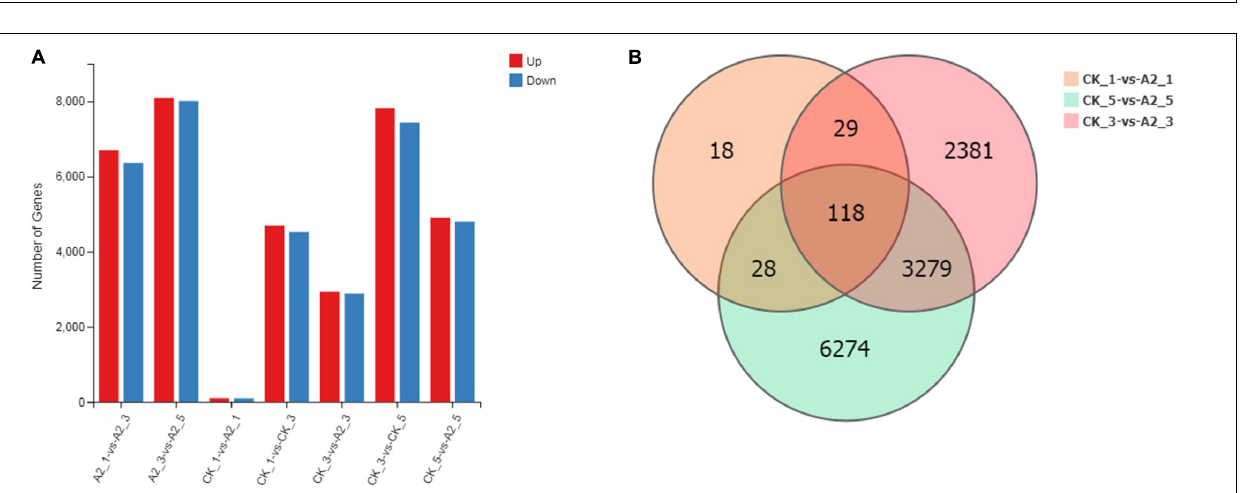
vs. A2_5 were further analyzed. In total, 4,453 DEGs